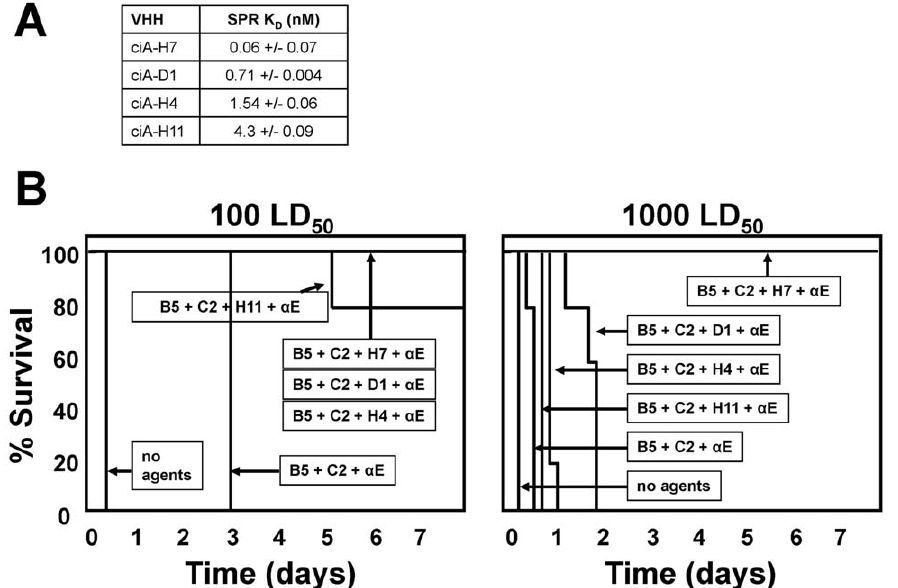
Figure 3. Anti-BoNT/A VHH protection from lethality improves with higher affinity VHHs. ( A ) The K D s for four anti-BoNT/A VHHs that each recognize the same epitope (epitope A1; Table 1) based on competition analysis. ( B ) Time to death is plotted as % survival following injection of the indicated dose of BoNT/A in groups of five mice co-administered with pools of different anti-BoNT/A VHHs and clearing Ab. Each VHH pool contained VHHs ciA-B5 and ciA-C2 and one of the four different VHHs recognizing BoNT/A epitope A1. The pool of ciA-VHHs or control (no agents) that were administered to the mice is indicated by arrows.